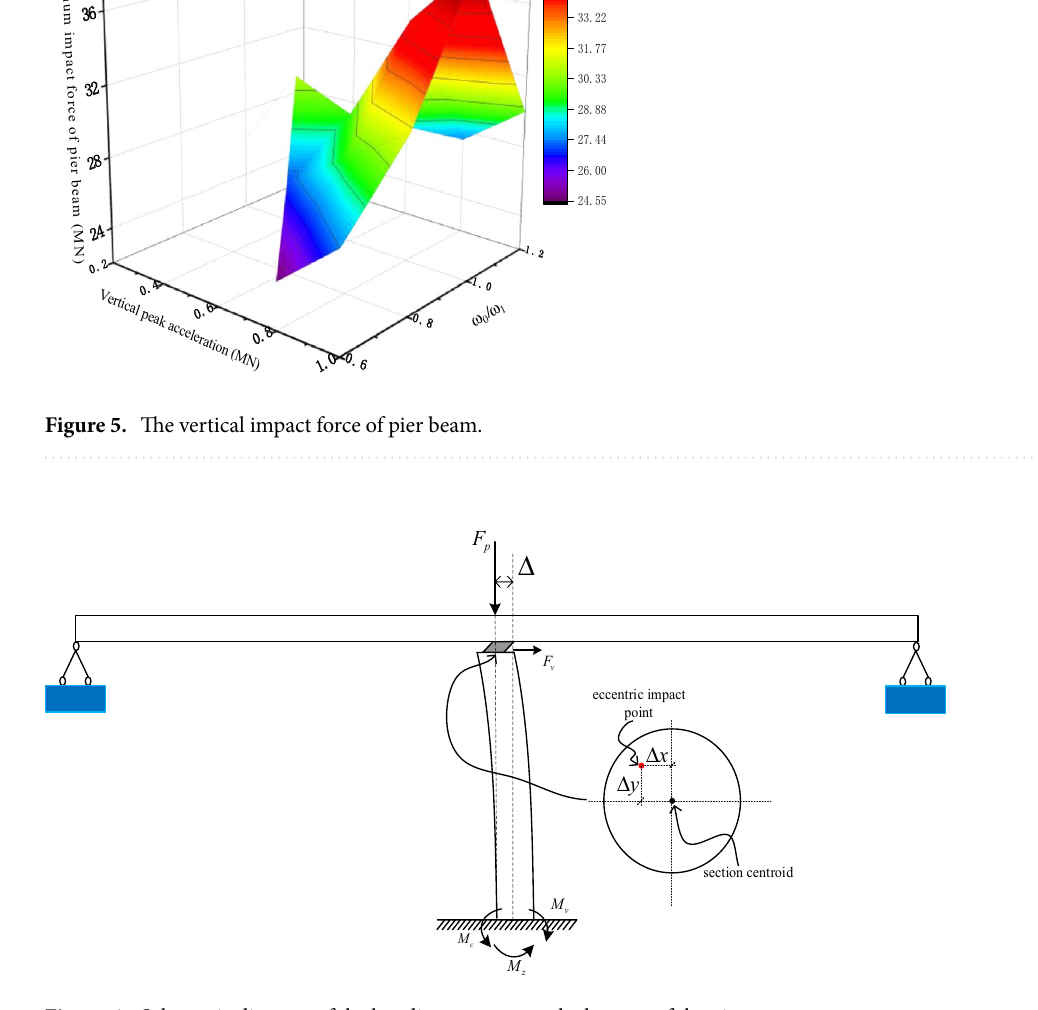
Therefore, the eccentric collision caused by separation may increase the bending moment of the pier or even cause the pier failure. Figure 8 shows the variation of horizontal bending moment of bridge piers under three conditions. Ignored the separation of pier and beam caused by vertical seismic excitation, with the increase of (cid:31) (V/H) amplitude; the combined bending moment goes from 1.81 to 2.6 MN m by 43.7%. The increase of vertical force will enlarge the eccentric impact moment. When structural separation is considered, the expanded deformation of 0th pier roof also increases eccentricity, the bending moment increases from 2.61 to 3.4 MN m. Therefore, when considering vertical seismic action, it is necessary to consider the vertical force and the separation that may occur. Influence of pier length on structural failure. Figure 9 shows the horizontal deformation of the pier top under different pier heights. The separation will increase the deformation at the top of the pier in both the lateral and longitudinal directions. But the trends in the two directions are different. In the lateral direction, the deformation of the pier top increases first and then decreases. In contrast, in the longitudinal direction, it increases monotonically. The reason for this situation is that the lateral natural vibration period of the bridge is affected by the main girder, while the longitudinal natural vibration period of the bridge is mainly affected by the pier. At the peak point of relative transverse displacement, the period of natural vibration of the bridge pier is close to the period of natural vibration of the bridge. In the longitudinal direction, the period of natural vibration of the pier is close to that of the bridge. The relative displacement increases with the increase of the pier height.